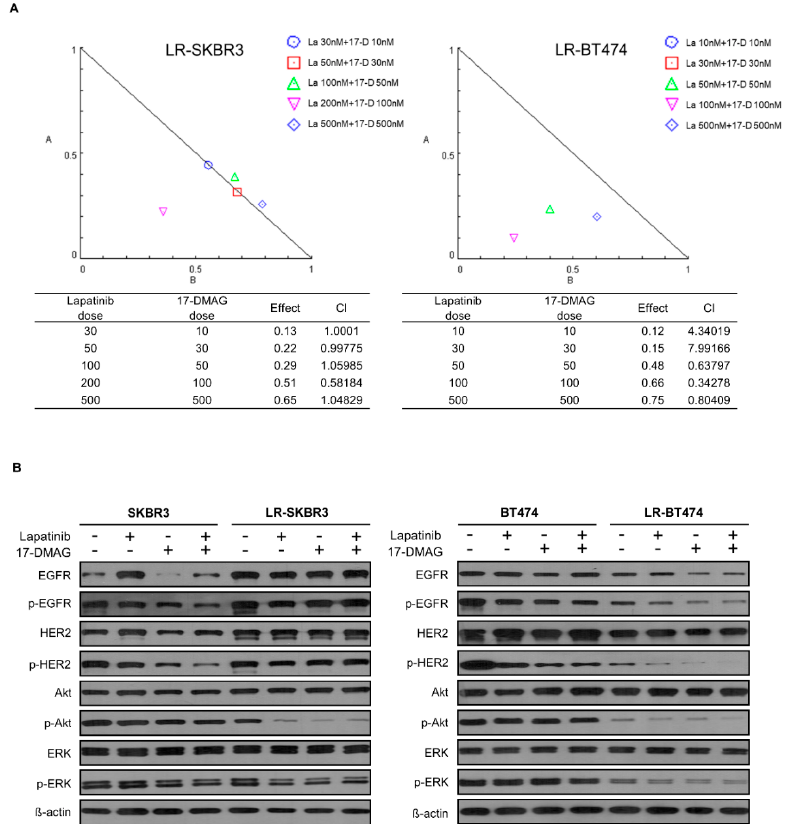
Figure 5. Combination of lapatinib and 17DMAG in lapatinib-resistant cell lines. ( A ) Isobologram plot shows combination treatment of lapatinib and 17-DMAG in LR-SKBR3 and LR-BT474 cell lines. ( B ) All cell lines were treated with lapatinib, 17DMAG, or combination lapatinib and 17DMAG for 24 h, lysed, and analyzed using western blot with indicated